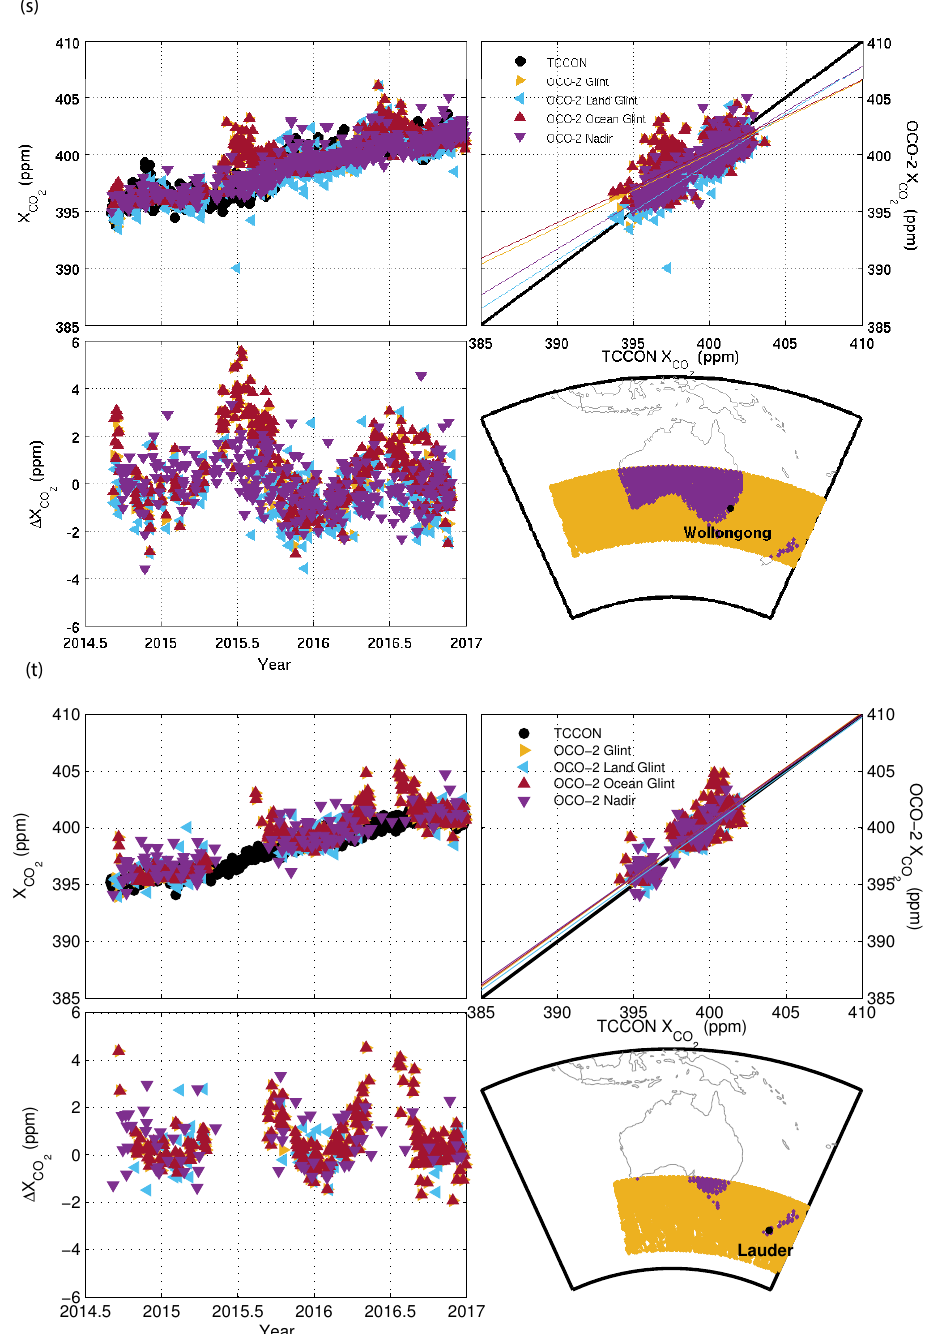
Figure A1. The top left panel of each plot (a–t) shows the time series of the TCCON daily medians (black circles) and the daily medians of the OCO-2 glint mode (gold triangles), split into land glint (blue triangles) and ocean glint (red triangles), and OCO-2 nadir mode (purple triangle). The bottom left panel shows the difference between the OCO-2 data and TCCON data as a function of time. The top right panel shows the one-to-one correspondence between the OCO-2 X CO values and the TCCON values, and the best fit lines in the colors 2 corresponding to the symbols. The one-to-one line is marked in black. The lower right panel shows the location of the TCCON station (black circle) and the locations of the OCO-2 data, showing glint-mode data in gold and nadir-mode data in purple. The lower right panel is intended to give a sense of the spatial coincidence criteria applied to the OCO-2 data for each TCCON